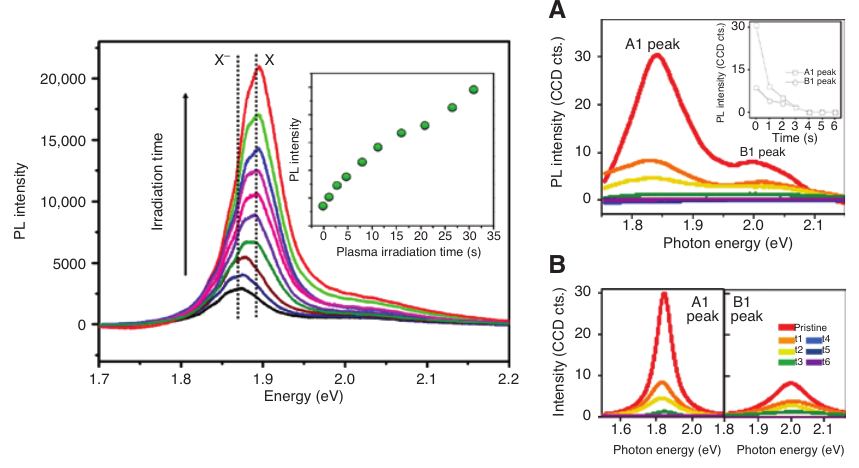
Figure 4: Photoluminescence quenching, taken from Ref. [51, 52]. after oxygen plasma irradiation with different durations. The change of PL intensities with plasma irradiation Left, PL spectra of SL MoS 2 times is shown in the inset. (Right, (A)) Time-dependent photoluminescence (PL) spectra of plasma-treated SL MoS intensity of A and B peaks (corresponding to SOC) with respect to the plasma exposure time from pristine SL MoS 1 1 curve). (B) Corresponding to A and B excitons, the peaks in PL spectra were fitted with Lorentzian functions. 1 1